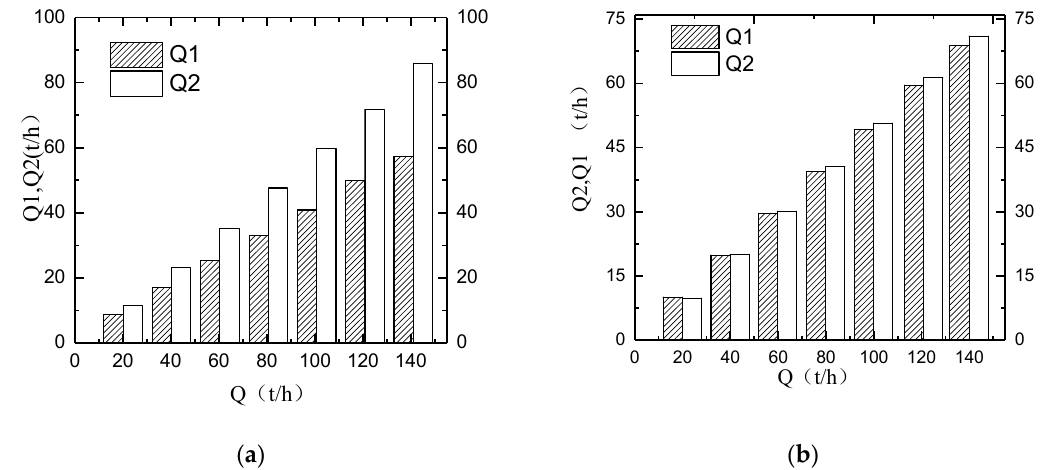
Figure 10. The flow distribution of branch at the temperature of 40 °C . ( a ) Without rectifier nozzle; ( b ) with rectifier nozzle.